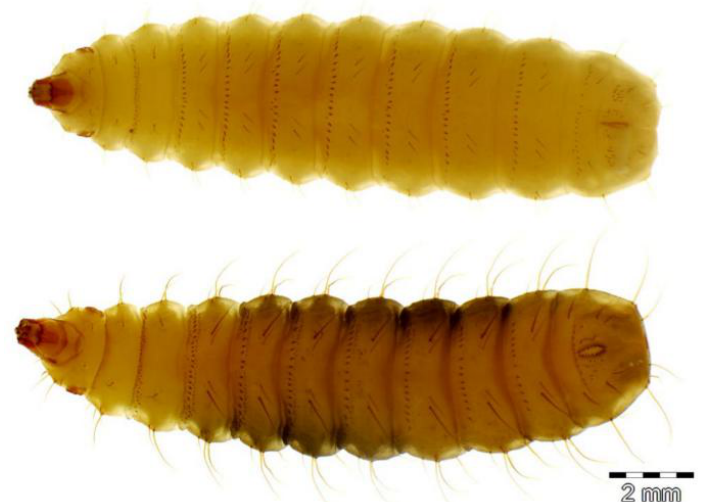
Figure 5. Habitus of the stratiomyid larvae of Hermetia illucens ( top ) and H. fenestrata ( bottom ) in ventral view.